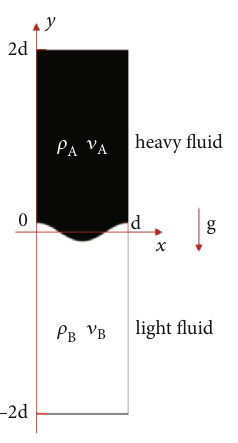
Figure 8: Schematic diagram for Rayleigh-Taylor instability.